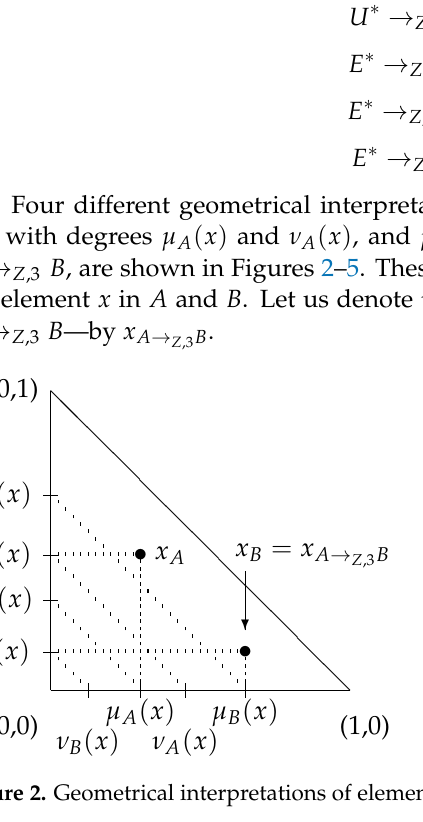
B – the first scenario 45 Figure 2. Geometrical interpretations of elements x A , x B and x A B —the first → Z ,3 → Z ,3